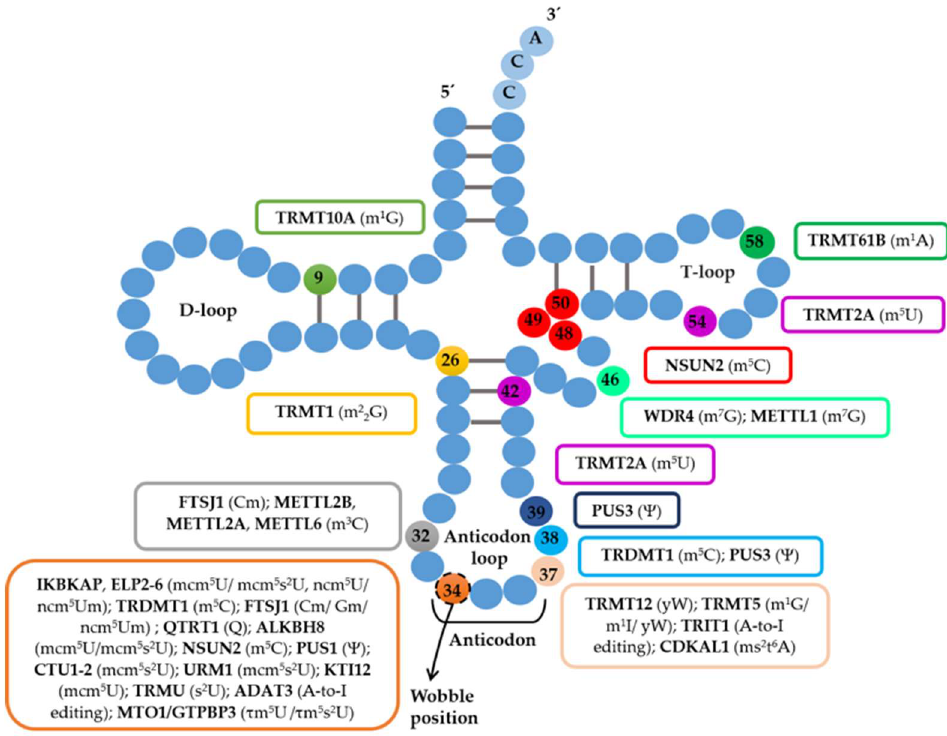
Figure 1. Schematic representation of the tRNA secondary structure with respective tRNA-modifying enzymes and modifications (in parenthesis). Connecting lines between RNA residues indicate base pairing.